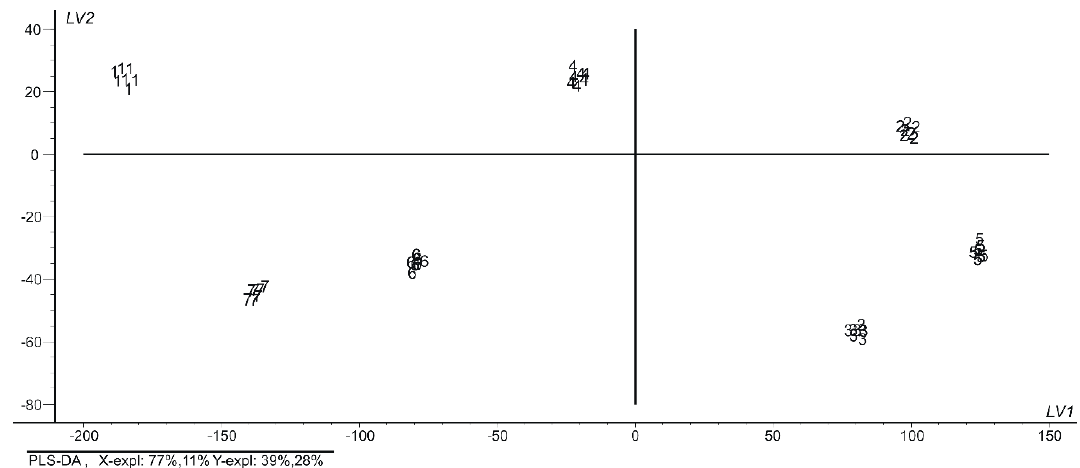
Table 3. Calibration and Validation PLS-DA results.